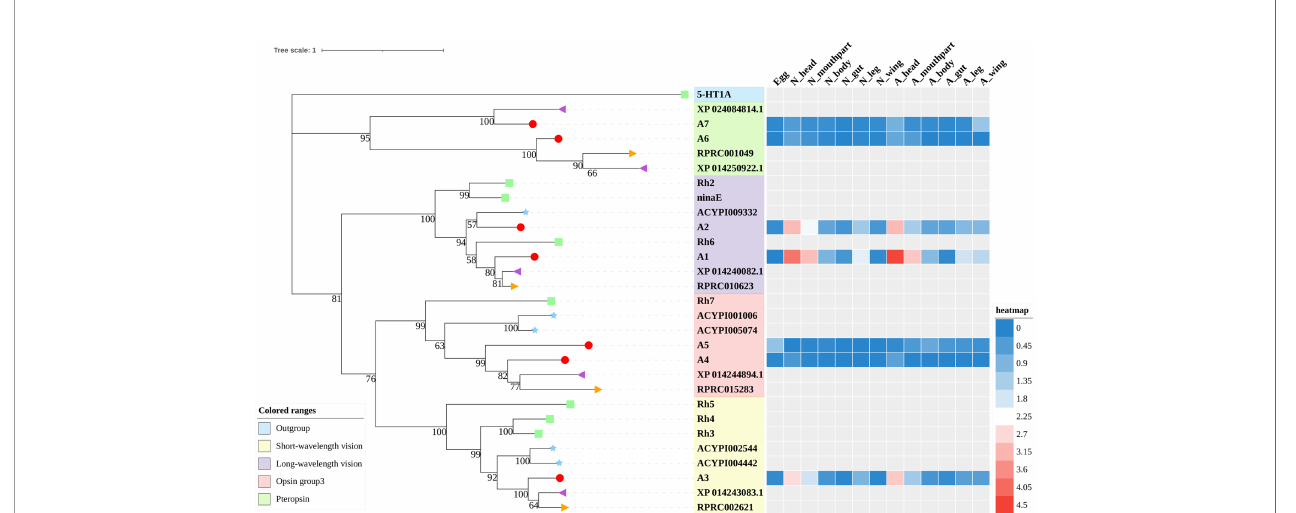
FIGURE 1 | Phylogenetic tree reconstruction of opsin GPCRs from D. melanogaster (green square), A. pisum (blue star), R. prolixus (orange right triangle), C. lectularius (purple left triangle), and A. lucorum (red circle) inferred from maximum likelihood (ML) analysis. Numbers at nodes on the tree were the bootstrap values (below 50 are not shown). The tree was rooted by the D. melanogaster biogenic amine receptor 5-HT1A. Expression pro fi les of A. lucorum GPCR genes from different tissues are shown in the corresponding branch side. The transcription level of each gene is represented by a square with a color that codes for the values of Lg (TPM+1). N, nymph; A, adult.